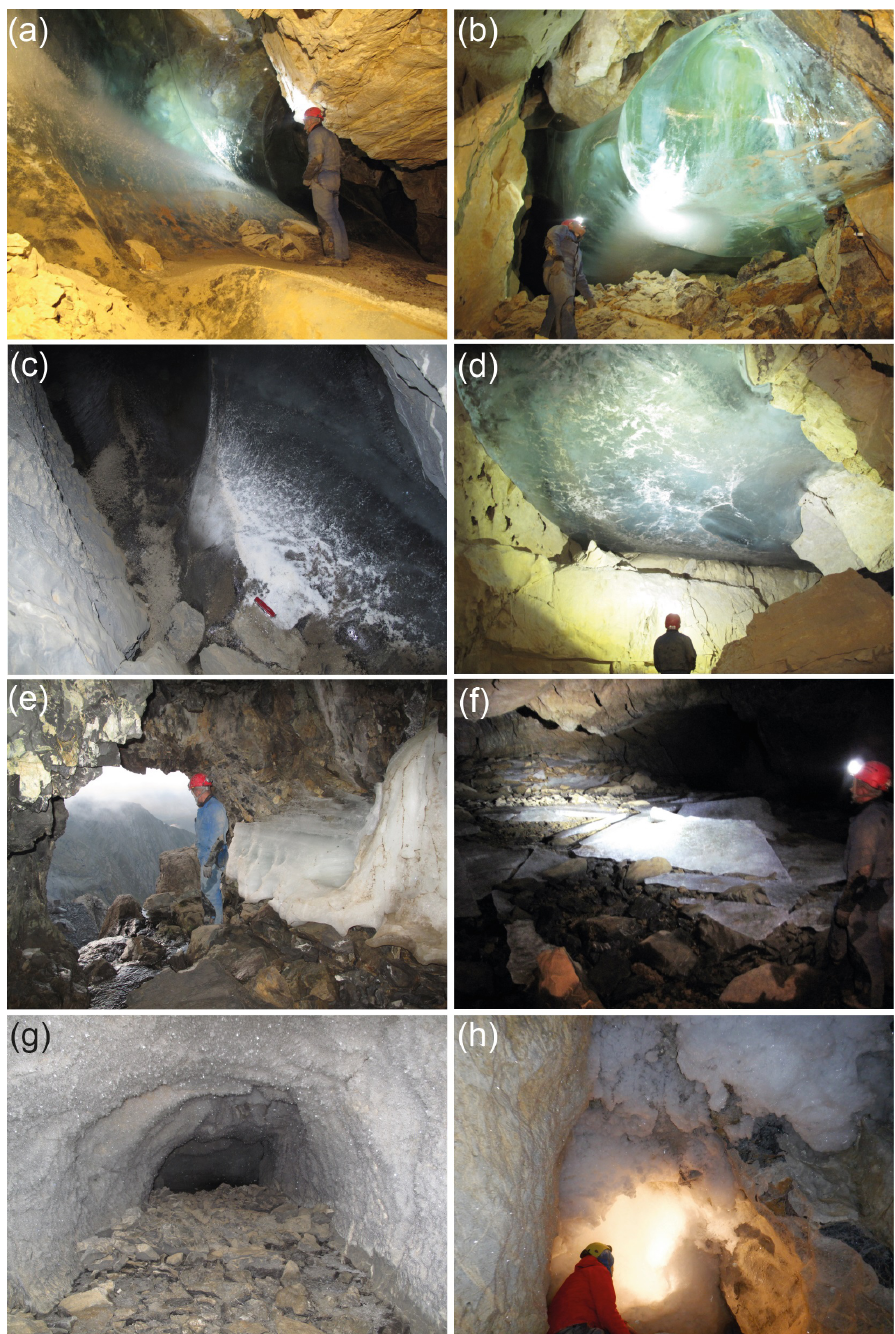
Figure 6. (a) Upper part of the ice body in room D. (b) Ice body hanging from the ceiling and the southwest wall in room G. White spots near the bottom of the deposit correspond to air inclusions, as well as cryogenic carbonates and gypsum in the ice. (c) Small ice body in room SPD with CCC and CCG on and within the ice. Red knife (9cm) for scale. (d) Ice body on the ceiling of room K (Terminus Devaux, TD). (e) Brulle spring and remains of a layered ice body (September 2018). (f) Broken ice sheets in the flooded area in room F (September 2018). (g) Millimetre- to centimetre-sized perennial hoarfrost in a blind gallery below room SPD. (h) Seasonal hoarfrost aggregates ( > 30cm long in size) covering a cupola close to room